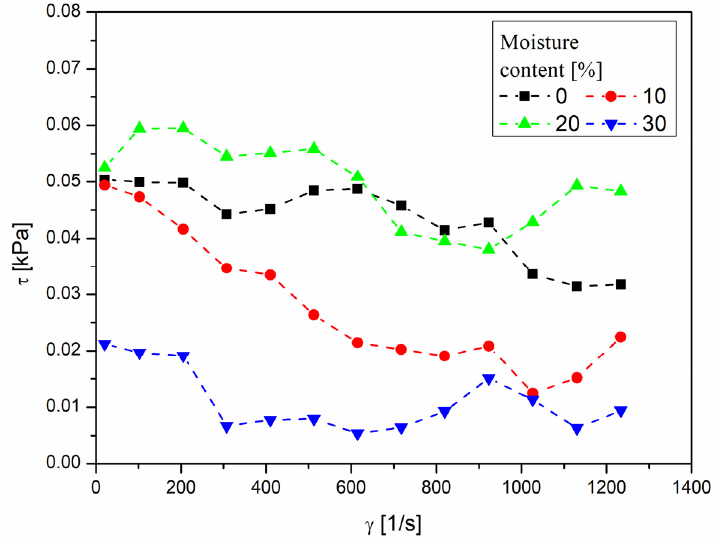
Figure 9. The influence of moisture content and shear rate γ ̇ on shear stress τ for hard coal.